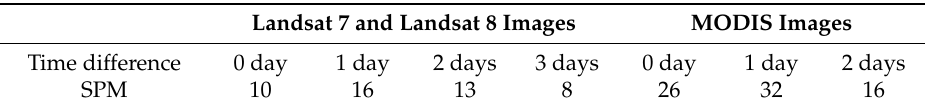
Table 2. Number of SPM in-situ data acquired with a time difference of 0, 1, 2 and 3 days from the date of the satellite data